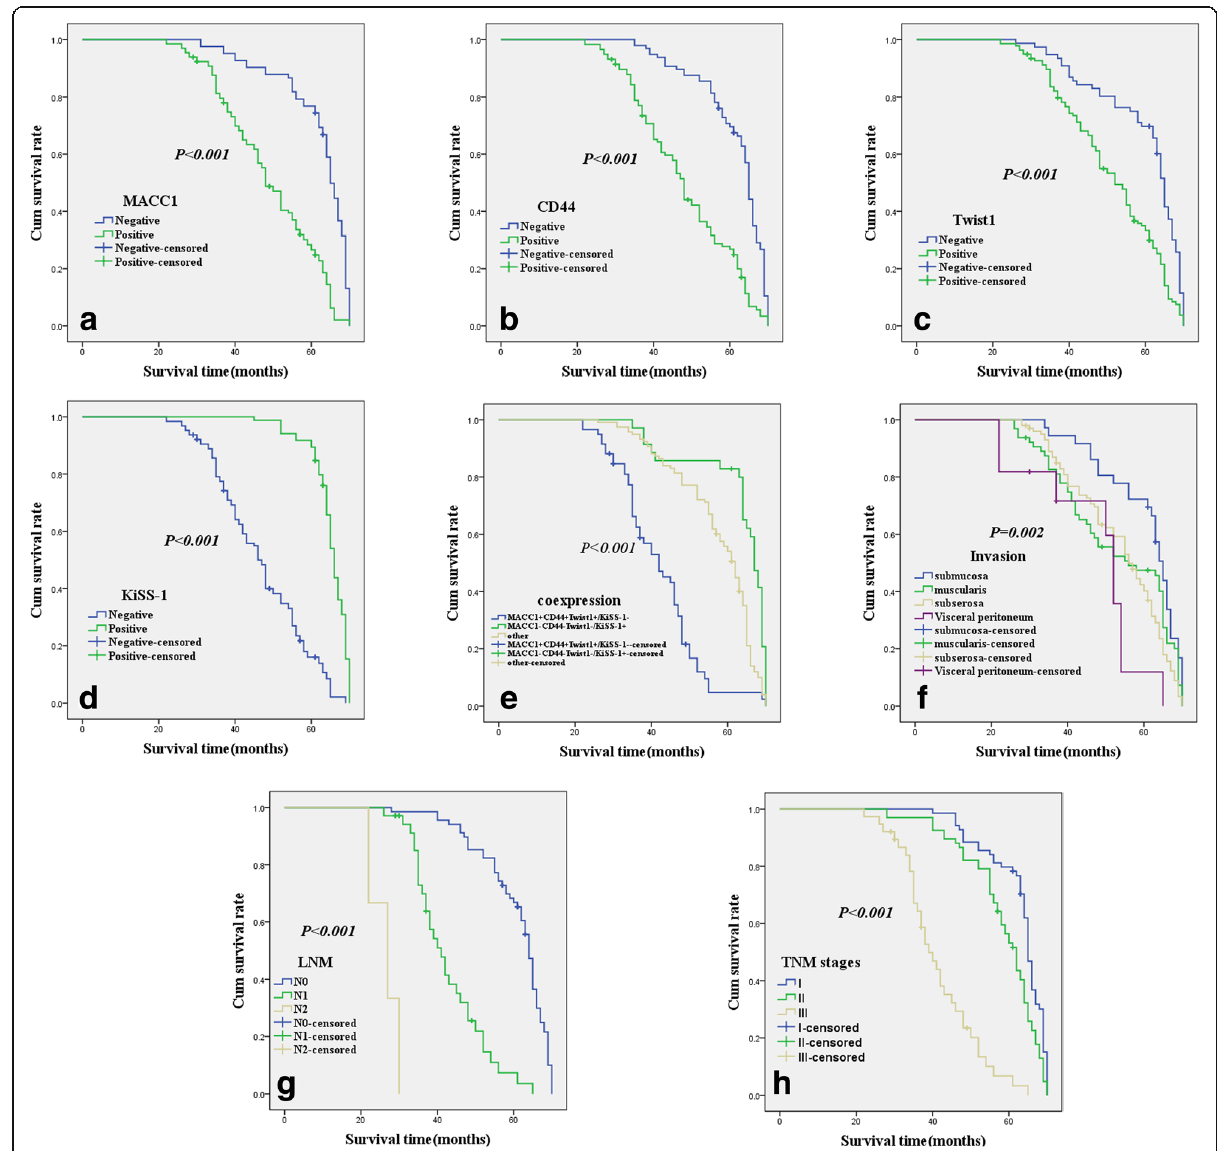
Fig. 2 Kaplan-Meier analysis curve of the survival rate of patients with CAC. The y-axis means the percentage of patients; the x-axis means their survival in months. a : OS analysis of all patients in relation to MACC1 (log-rank = 61.757, P < 0.001); b : OS analysis of all patients in relation to CD44 expression (log-rank = 54.938, P < 0.001); c : OS analysis of all patients in relation to Twist1 expression (log-rank = 24.306, P < 0.001); d : OS analysis of all patients in relation to KiSS-1 expression (log-rank = 115.258, P < 0.001). In (a) , ( b) , ( c) and ( d) analyses, the green line represents patients with positive MACC1, or CD44, or Twist1 or KiSS-1; the blue line representing the negative MACC1, or CD44, or Twist1 or KiSS-1 group. E: OS survival of all patients in relation to the combination of KiSS-1, MACC1, CD44, and Twist1 expression (log-rank = 84.625, P < 0.001). The green line represents negative KiSS-1 and positive MACC1, CD44, Twist1 and the blue line represents positive KiSS-1 and negative MACC1, CD44, Twist1. The brown line represents other positive or negative proteins. F: OS survival of all patients in relation to tumor invasion depth (log-rank = 14.868, P = 0.002); G: OS survival of all patients in relation to LNM stages (log-rank = 325.068, P < 0.001); H: OS survival of all patients in relation to TNM stages (log-rank = 152.179, P <